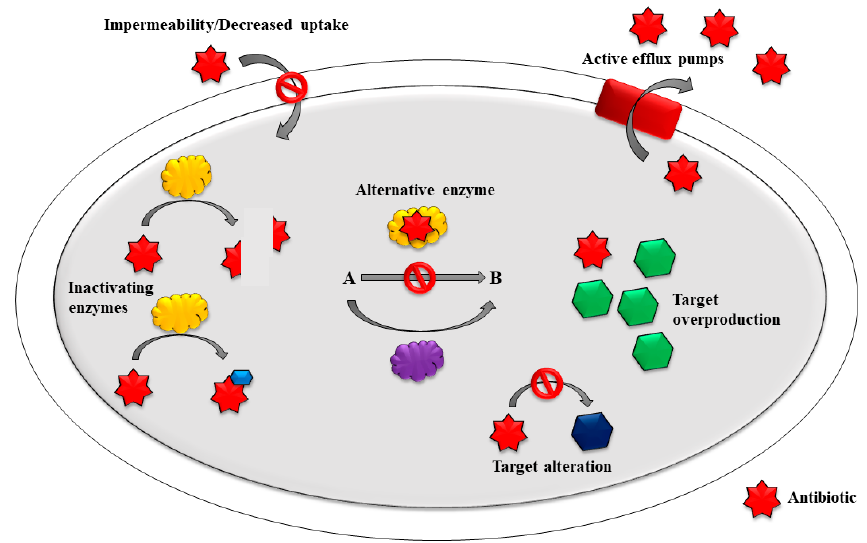
Figure 1. Mechanisms of antibiotic resistance; CC-BY-4.0 license.